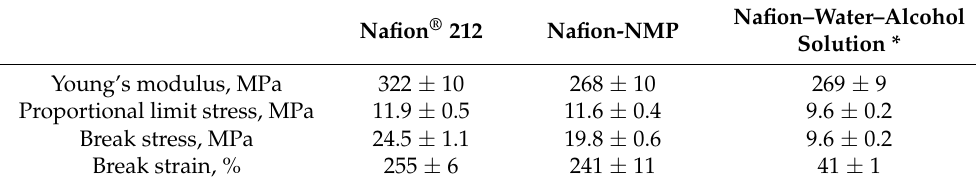
Figure 3. Stress – strain curves of Nafion ® 212, Nafion-NMP membranes kept at RH = 32% in com- Figure 3. Stress–strain curves of Nafion ® 212, Nafion-NMP membranes kept at RH = 32% in compari- parison with membrane obtained via casting procedure from water – alcohol solution of Nafion, de- son with membrane obtained via casting procedure from water–alcohol solution of Nafion, described scribed in [38]. in [38]. Table 1. Mechanical properties of membranes kept at RH = 32%. Table 1. Mechanical properties of membranes kept at RH =